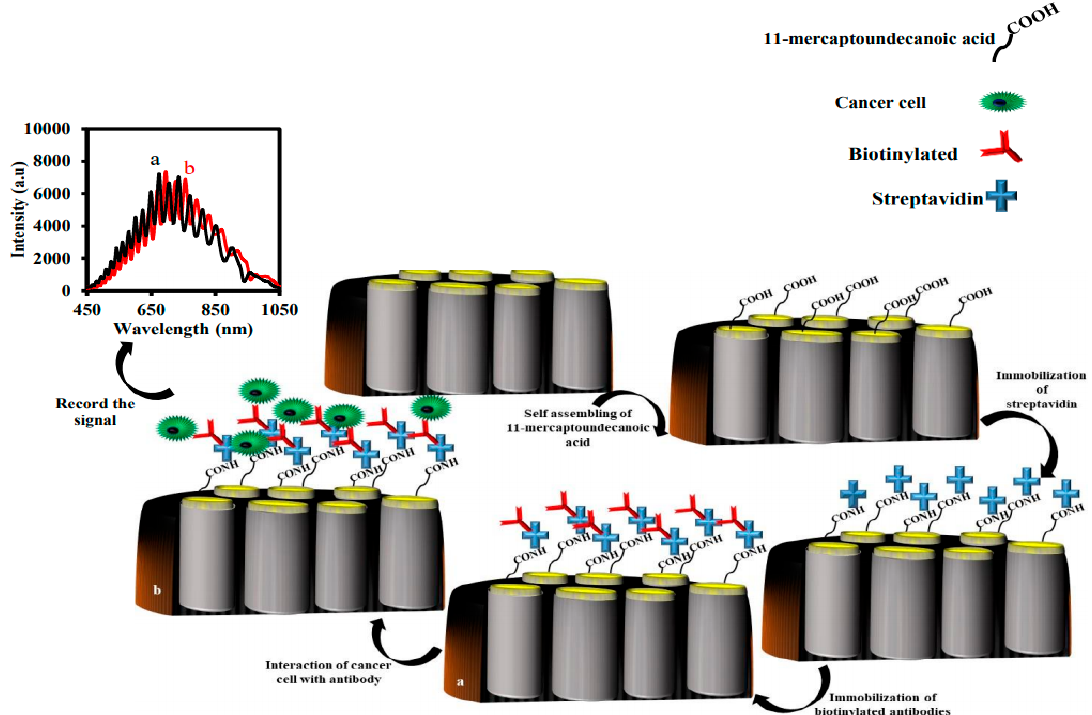
Figure 4. Schematic representation of the fabrication of the nanoporous anodic alumina-anti-epithelial cell adhesion molecule antibody (NAA-anti-EpCAM) for the determination of CTCs using interferometric reflectance spectroscopy (IRS).